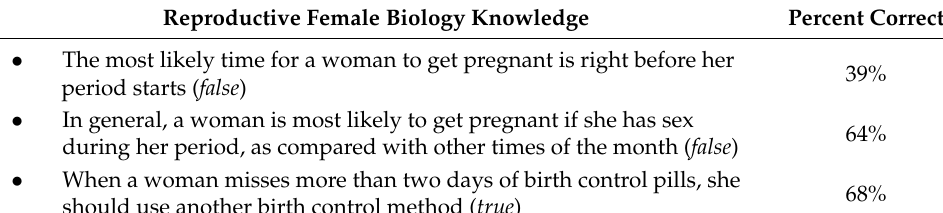
Table 1. True/False Questions Comprising the Survey Outcomes (RDSL; n =